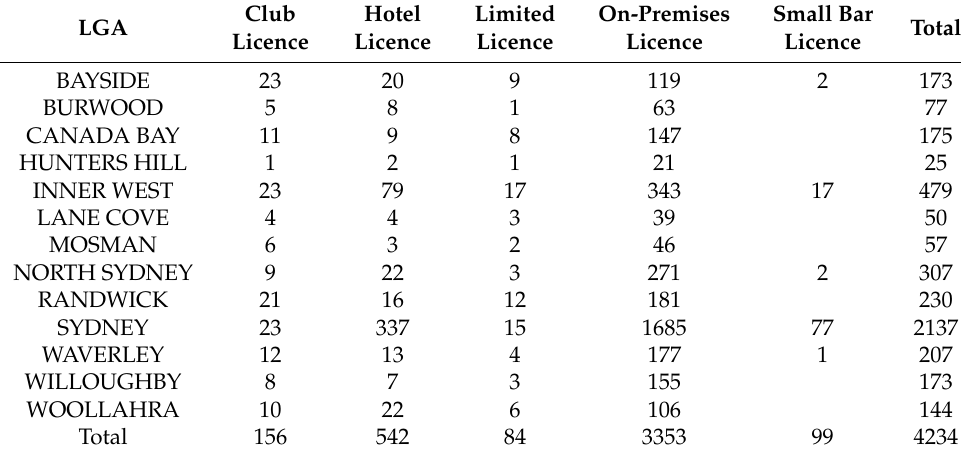
Table 1. Licensed venues per local government area